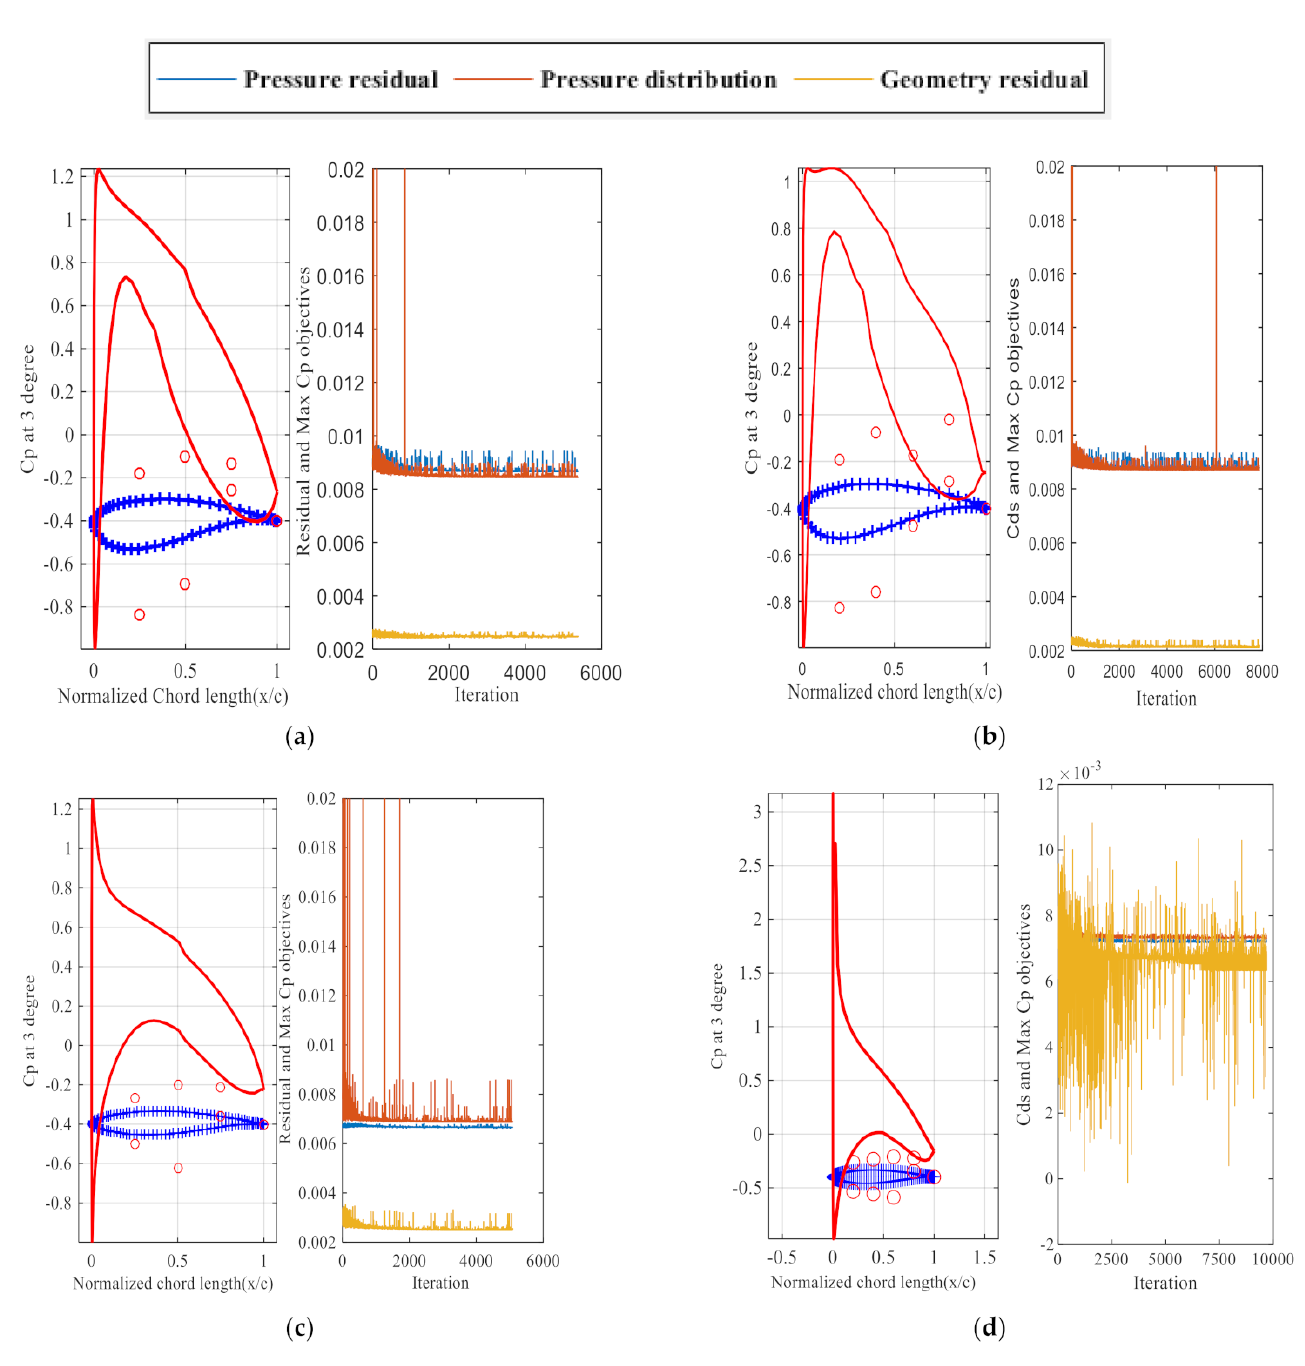
Figure 13. The convergence process and error bars with the generation corresponding to CST method. ( a ) NREL S-821 ( n =6), ( b ) NREL S-821 ( n = 8), ( c ) RAE-2822 ( n = 6), ( d ) RAE-2822 ( n =